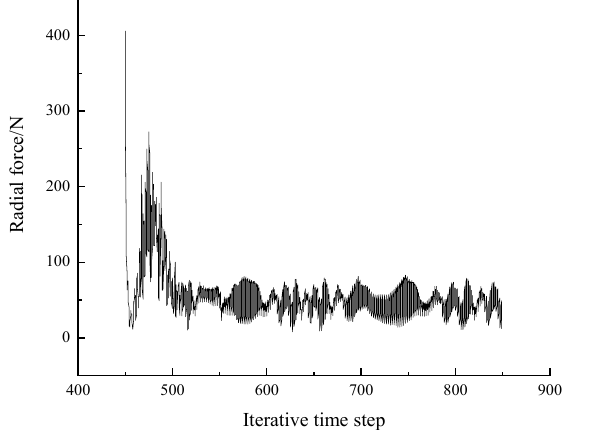
Figure 7. Transient radial force curve of impeller during centrifugal pump startup.